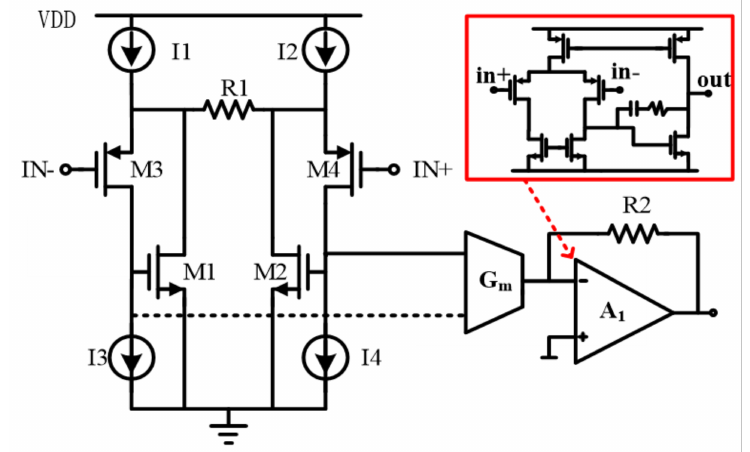
Figure 10. Topology of the readout circuit.